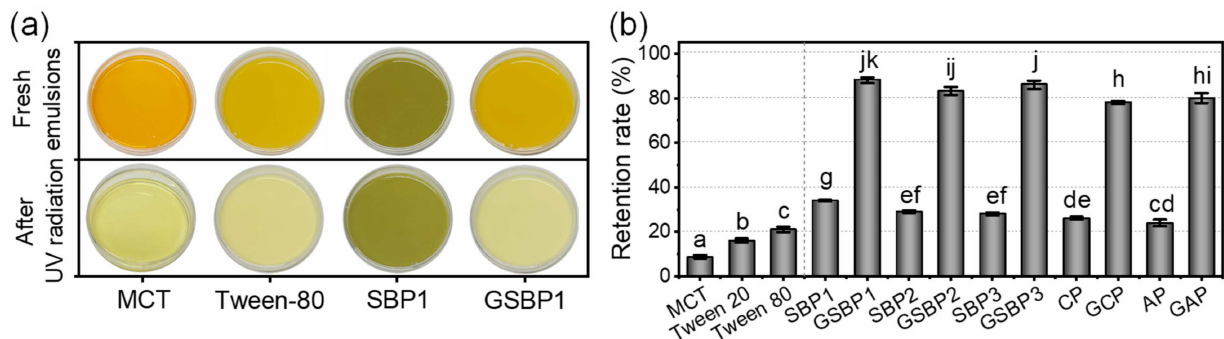
Figure 4. Visual appearance ( a ) and retention rate ( b ) of β -carotene loaded in MCT, Tween-stabilized emulsions, and pectin-stabilized emulsion after 10 h UV radiation. In panel b, the different letters on the column indicate statistically significant differences ( p < 0.05) among the